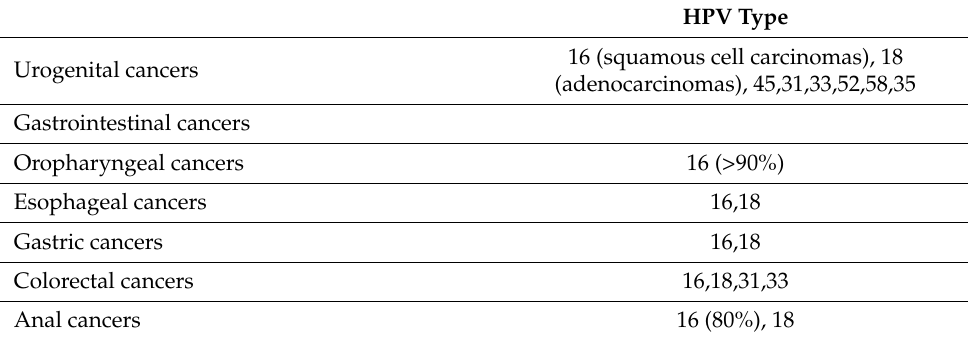
Table 5. Prevalent HPV types in urogenital and gastrointestinal cancers